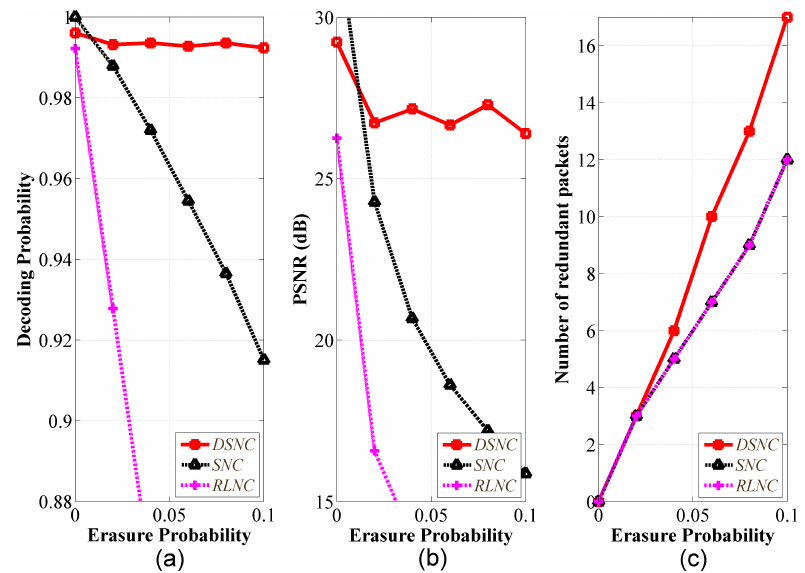
Figure 10. Performance comparison with adaptive method for redundancy with Lena image and size of 501 KB; ( a ) decoding probability; ( b ) PSNR; ( c ) number of redundant packet; generation size of 100, q =